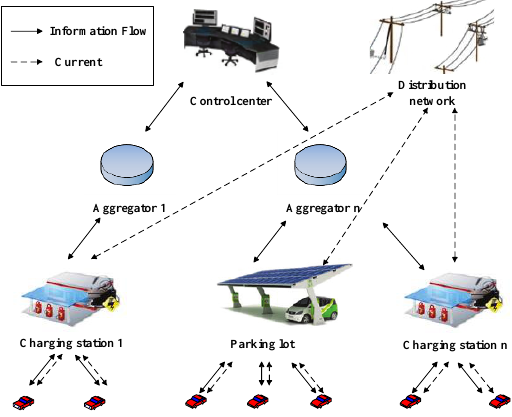
Figure 1. Network structure of V2G in smart